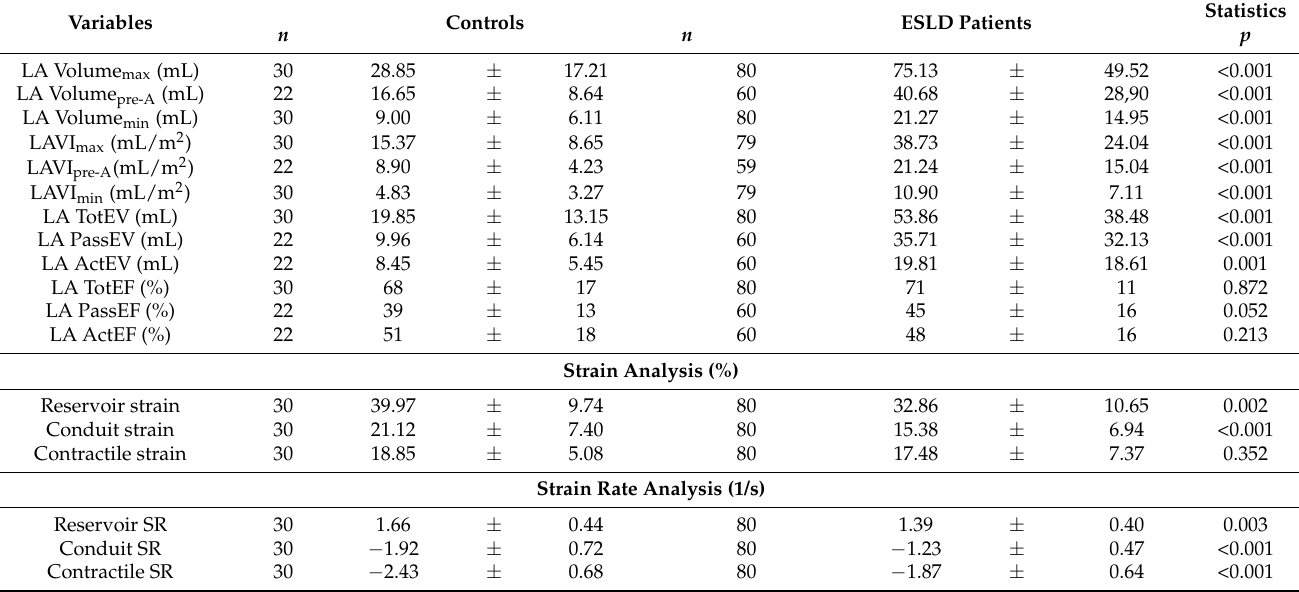
Table 4. Echocardiographic parameters of the left